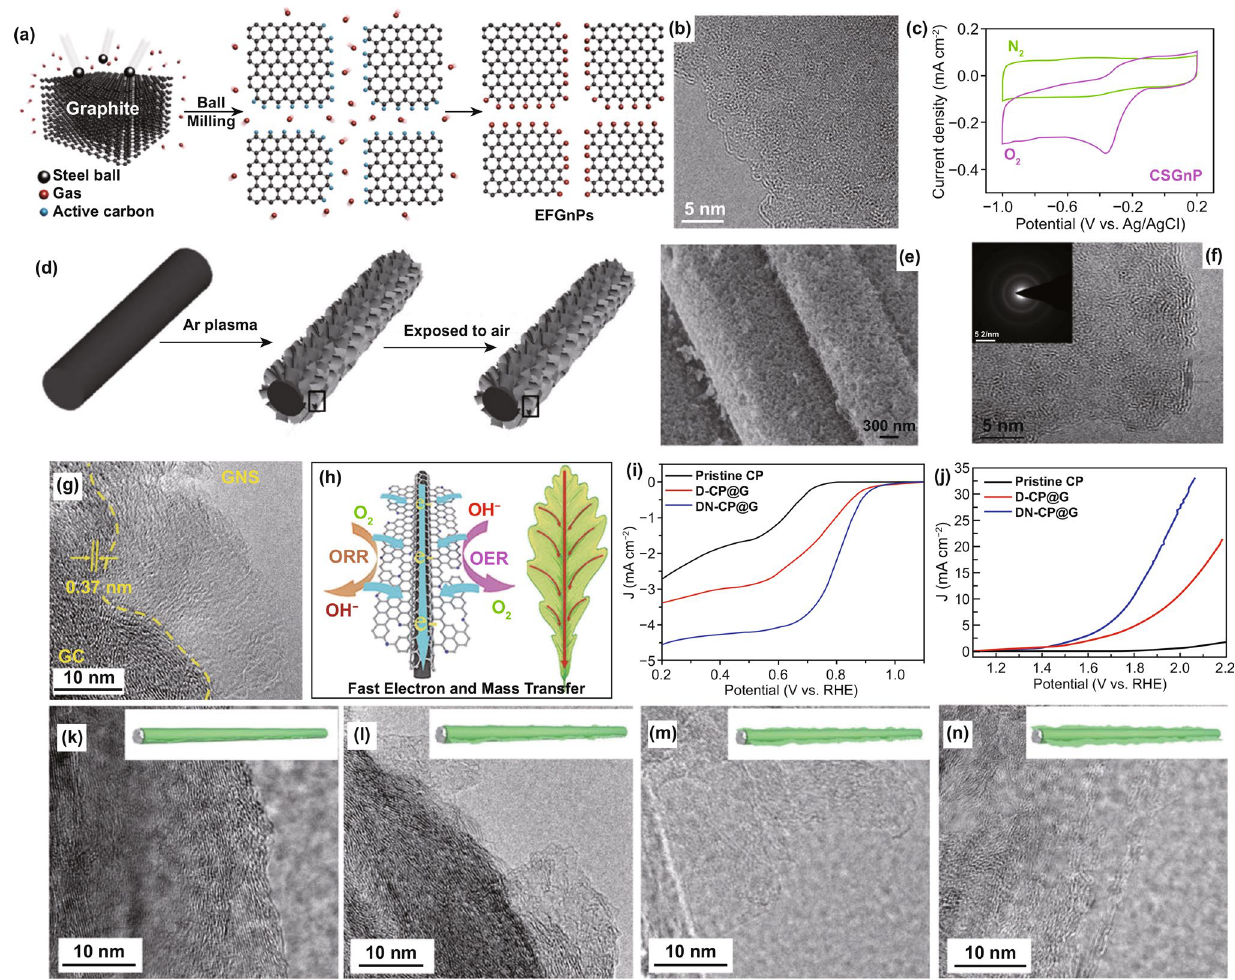
Fig. 5 Edge defects coupled with dopants in nanocarbon for ORR. a Schematic representation of edge-functionalized graphene nanoplatelets (EFGnPs); b TEM image of EFGnPs; c CV curves for CSGnP catalyst. Reproduced with permission from Ref. [67]. Copyright 2013, American Chemical Society. d Schematic representation of edge-rich and oxygen-functionalized graphene from carbon fiber. e , f TEM image of DN- CP@G. Reproduced with permission from Ref. [64]. Copyright 2014, Wiley–VCH. g TEM image of DN-CP@G; h schematic representation of the electrocatalytic characteristic of DN-CP@G; i , j ORR and OER activities of pristine CP, and non-doped D-CP@G and DN-CP@G catalysts; k – n TEM images of CP-based materials with controlled reaction time from 4 to 16 h. Reproduced with permission from Ref. [156]. Copyright 2014,